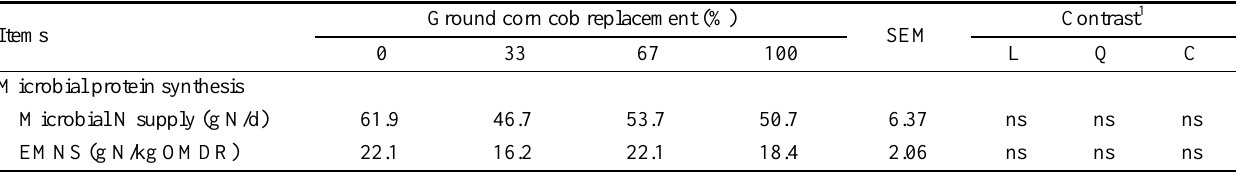
Table 4. Effect of ground corn cob replacement on microbial protein synthesis in swamp buffalo